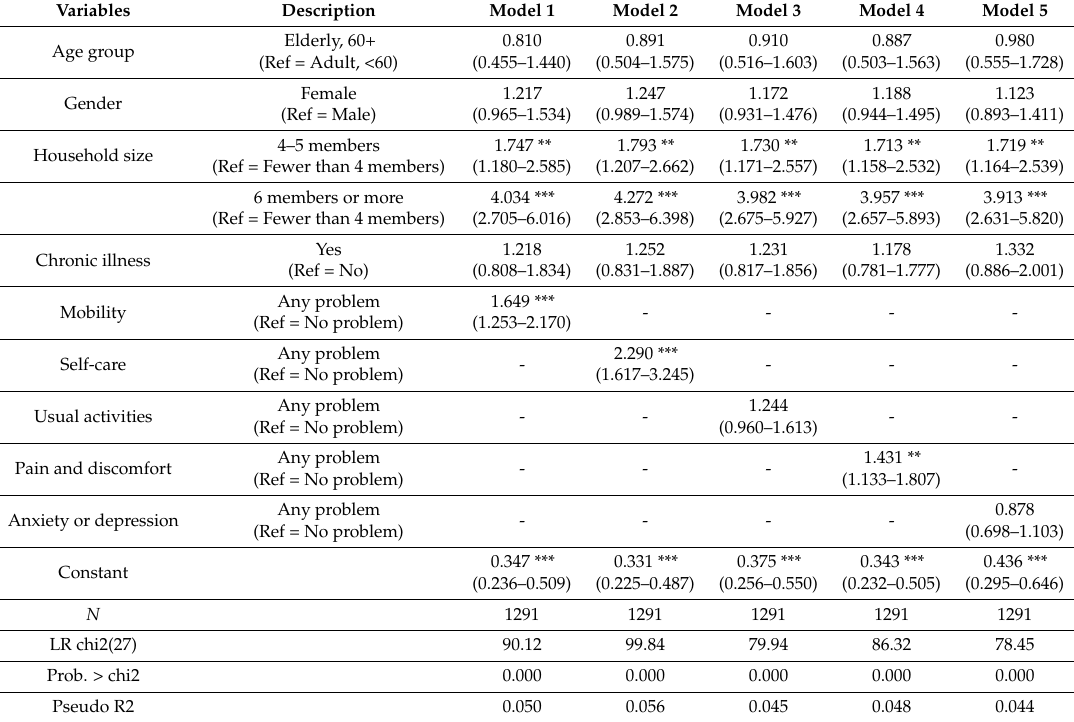
Table 4. Association between EQ-5D dimensions and CBHI